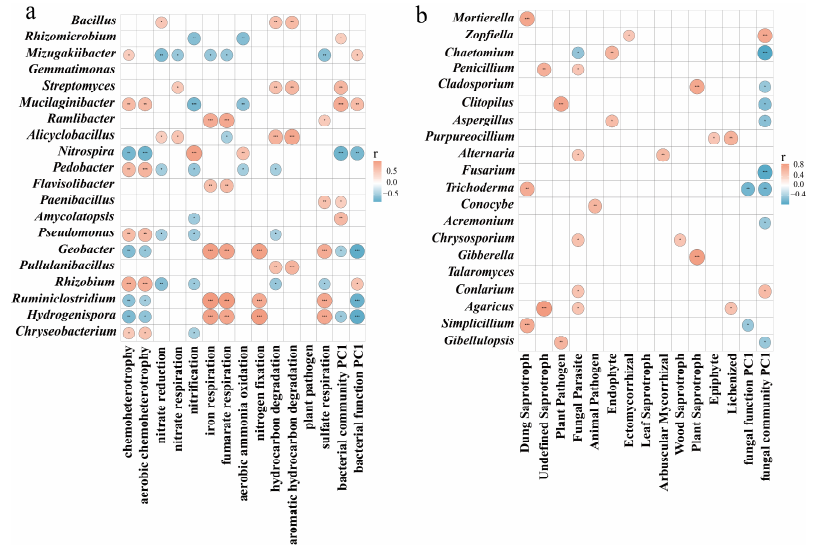
Figure 5. Pairwise spearman’s correlations between the relative abundances of dominant genera and microbial functions and β diversity. ( a ) Relationships between the relative abundances of bacterial dominant genera and functional compositions. ( b ) Relationships between the relative abundances of fungal dominant genera and functional compositions. * p < 0.05, ** p < 0.01, *** p < 0.001, and the blank indicates p > 0.05. Blue and red colors indicate the negative and positive correlations, respectively.